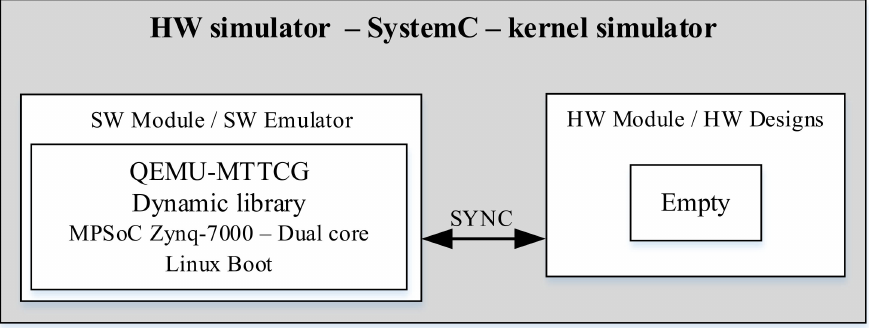
Figure 7. Setup#3. QEMU-MTTCG inside a co-simulation virtual platform as software (SW)